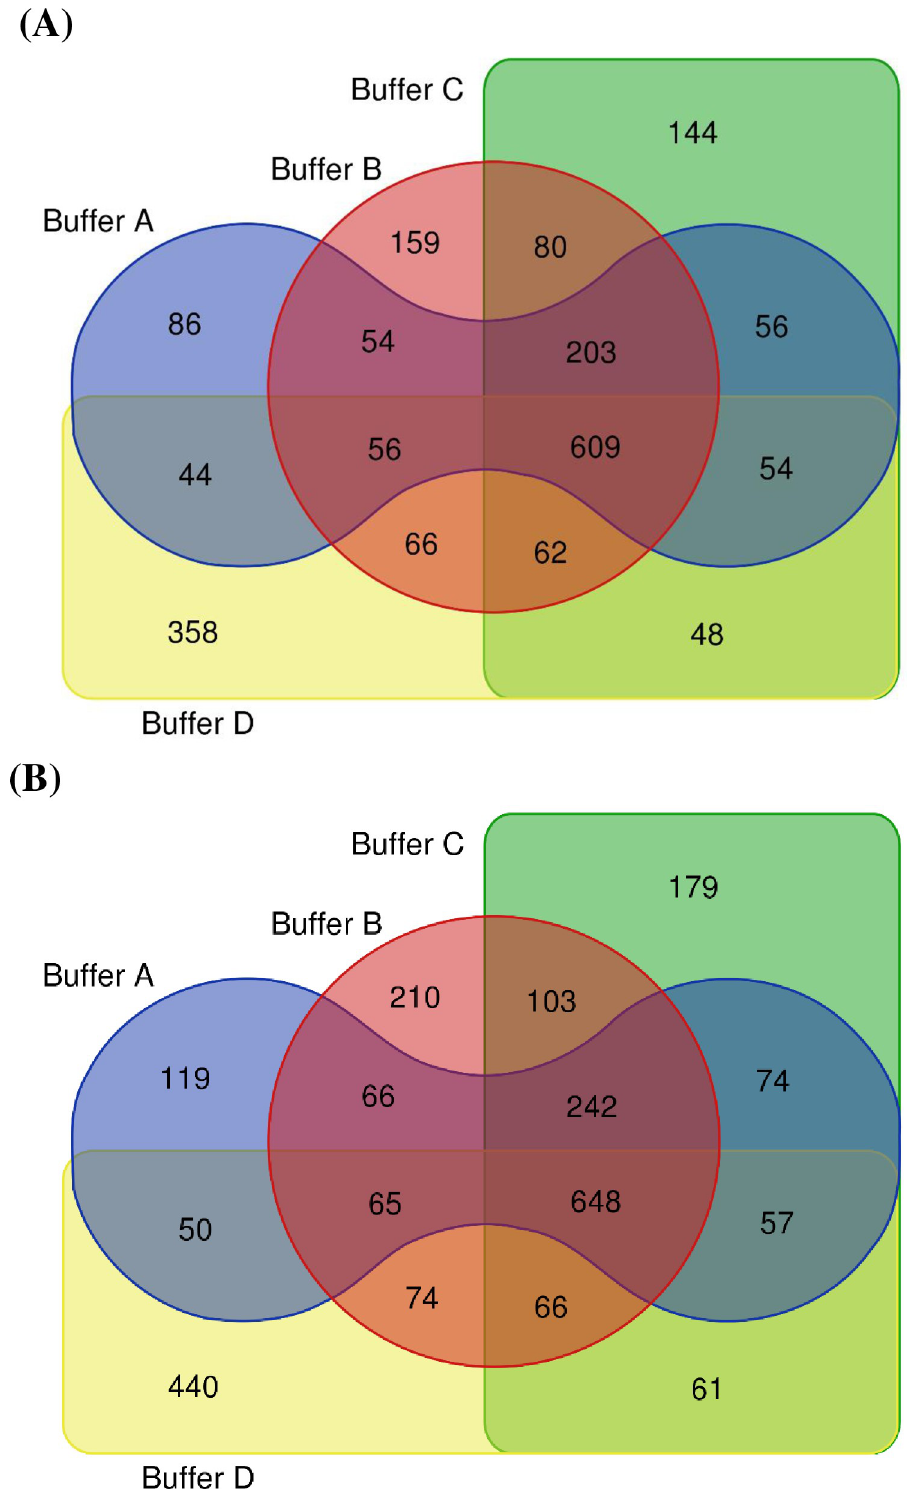
Fig 3. Venn diagrams of (A) proteins and (B) peptides, searched and identified using SEQUEST-HT protein search engine from four different solubilization buffers (Buffer A-D). Buffer A: Urea/thiourea/CHAPS; Buffer B: Urea/ CHAPS; Buffer C: Urea/Sodium deoxycholate; Buffer D: Sodium deoxycholate.